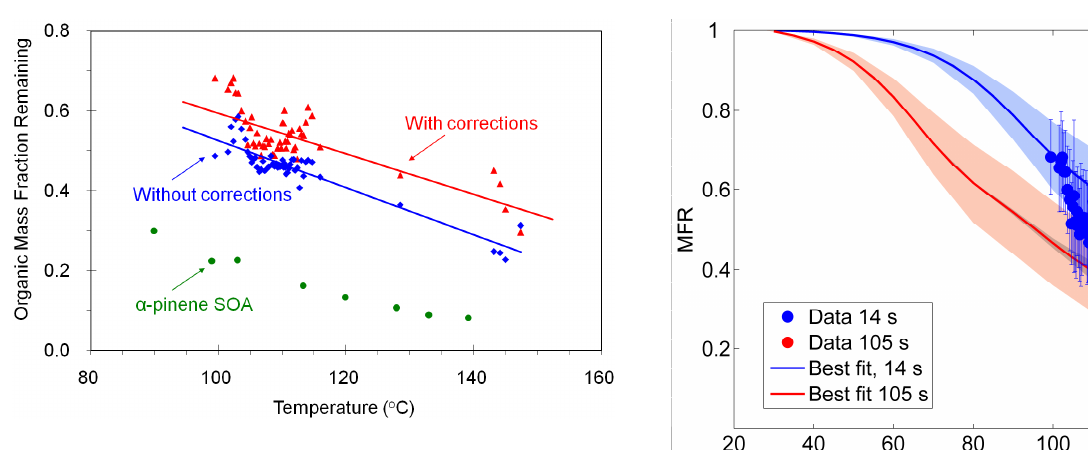
Fig. 6. Mass fraction remaining after heating in the TD (for 14s) Figure 6. Mass fraction remaining after heating in the TD (for 14 s) as a function of as a function of temperature for uncorrected TD-AMS data, cor- rected (for the losses in TD and the changes in AMS collection temperature for uncorrected TD-AMS data, corrected (for the losses in TD and the changes in efficiency and density) data during FAME-2008. Each data point AMS collection efficiency and density) data during FAME-2008. Each data point is the is the average of 30 MFR data sets (each MFR data set is 24min average of 30 MFR data sets (each MFR data set is 24 min averaged). Also plotted is the averaged). Also plotted is the thermogram of fresh lab-generated α - thermogram of fresh lab-generated α-pinene SOA with mass concentration of approximately pinene SOA with mass concentration of approximately 10µgm − 3 10 µg m -3 and size of approximately 250 nm. Lines are linear fits to guide the eye. and size of approximately 250nm. Lines are linear fits to guide the eye.